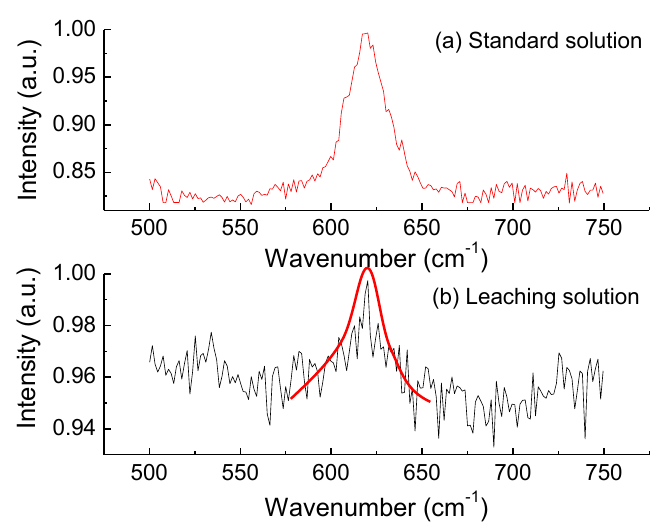
Figure 2. Raman spectrum of a standard solution and the leaching solution. ( a ) standard solution, ( b ) leaching solution.